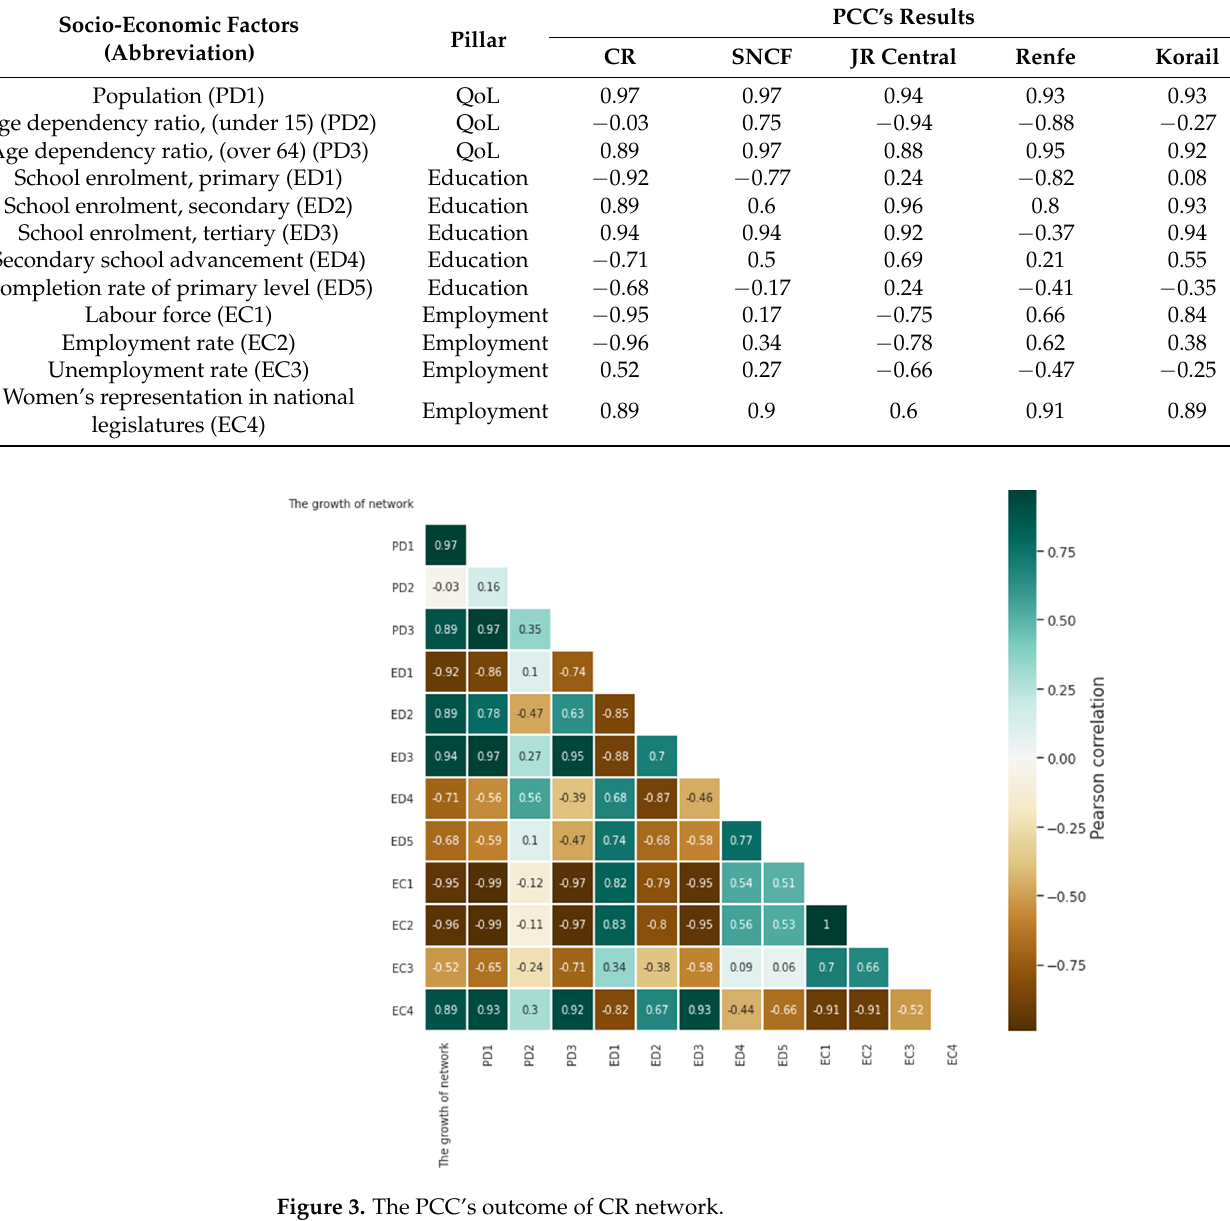
Table 3. The summarisation of PCC results among five HSR networks.